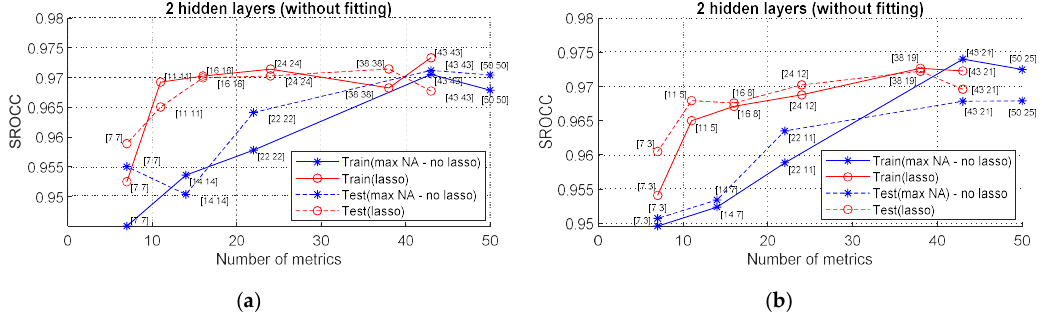
Figure 4. SROCC values for NNs with two hidden layers with different numbers of inputs: ( a ) equal number of neurons in hidden layers; ( b ) twice smaller number of neurons in hidden layers.